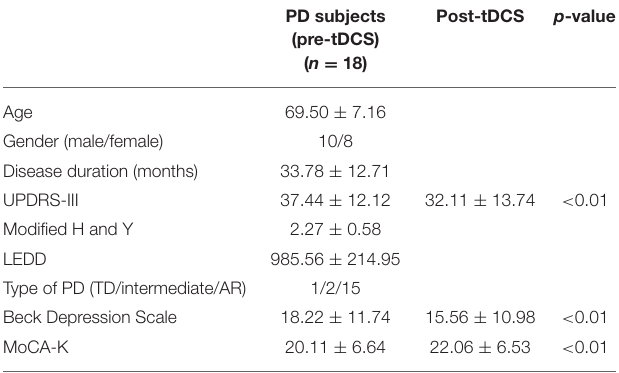
TABLE 1 | Baseline demographic and clinical parameters of the enrolled PD subjects before/after anodal tDCS application.